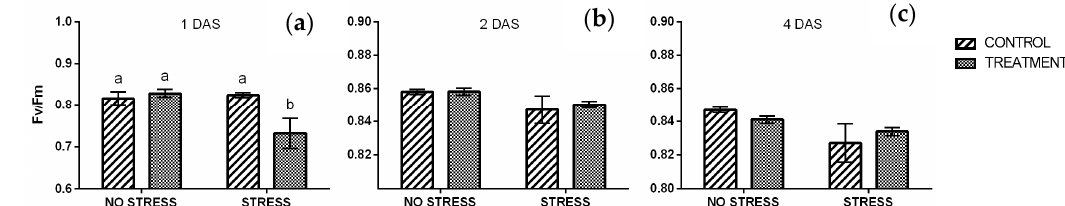
Figure 5. Maximum quantum e ffi ciency of PSII (Fv / Fm) measured in rocket leaves treated with water (CONTROL) and with borage extract (TREATMENT) and subjected to salt stress (200 mM). Measures were taken one day ( a ), two days ( b ) , and four days ( c ) of stress. Values are means ± SE ( n = 9). Data were subjected to two-way ANOVA. Di ff erent letters, where present, represent significant di ff erences ( p < 0.05).